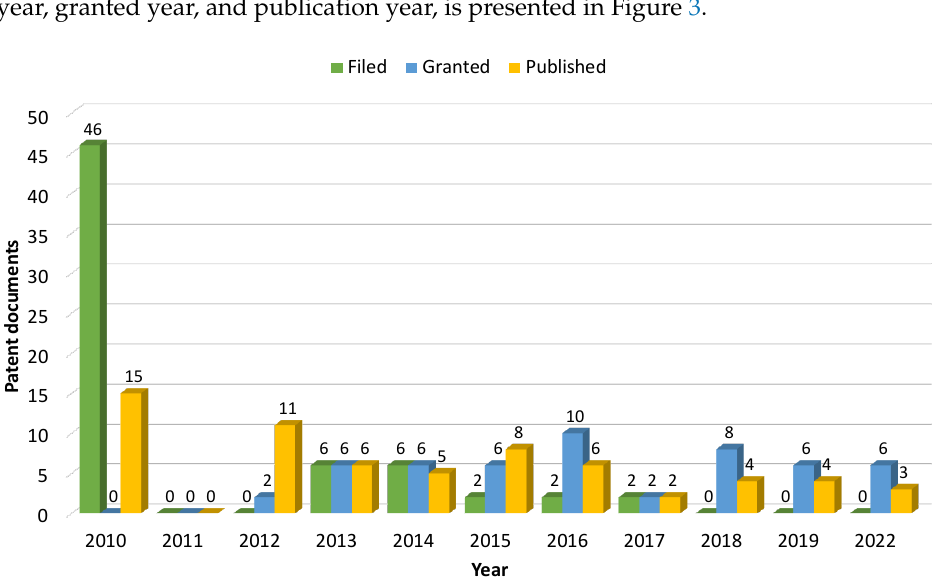
Figure 3. Filed, granted, and published patents concerning the 64 related patent families of the US9347177B2 patent [15].